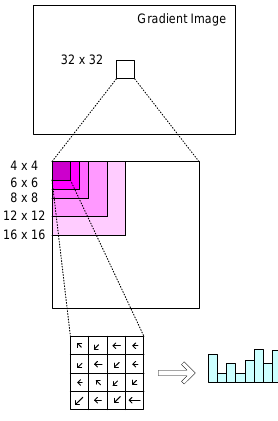
Figure 3: Steps of creating a HoG feature